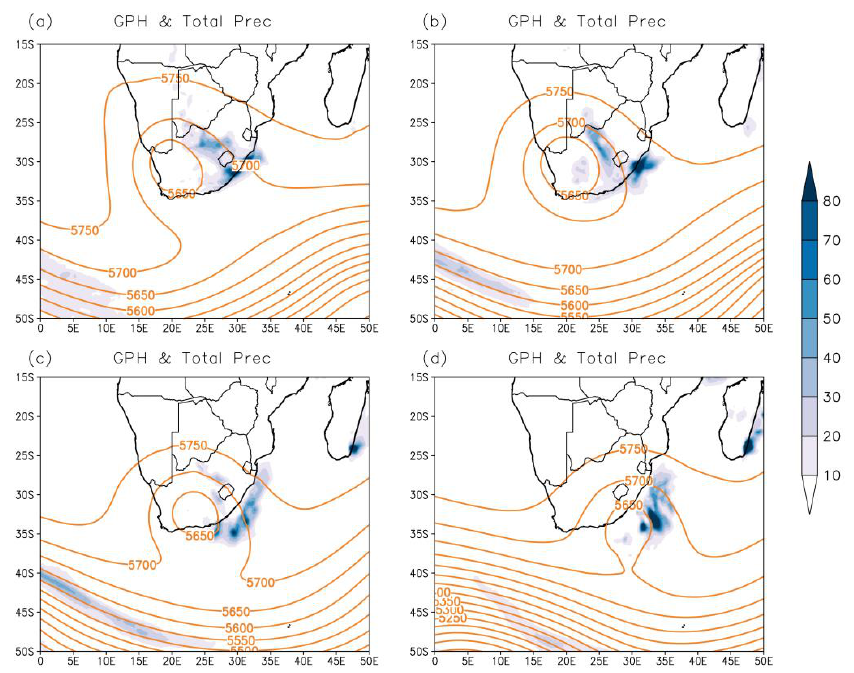
Figure 8. Geopotential height (m) 500 hPa and total rainfall (mm) during ( a ) 22, ( b ) 23, ( c ) 24, ( d ) 25 April 2019.